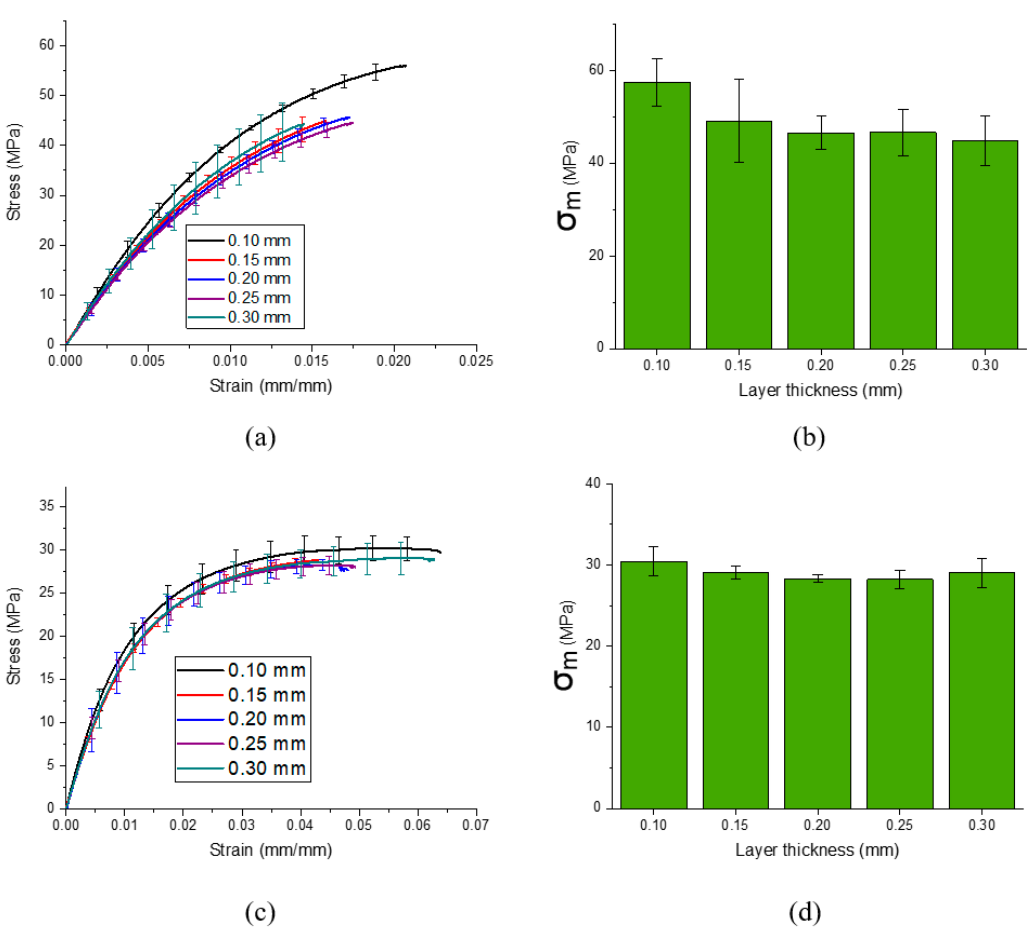
Figure 5. Results of mechanical tests: ( a , c ) stress–strain curves of the printed samples with raster angles of (90, 90) and (45, 135), respectively; ( b , d ) bar charts representing ultimate tensile strength, dependent on layer thickness, for the samples with raster angles of (90, 90) and (45, 135), respectively.